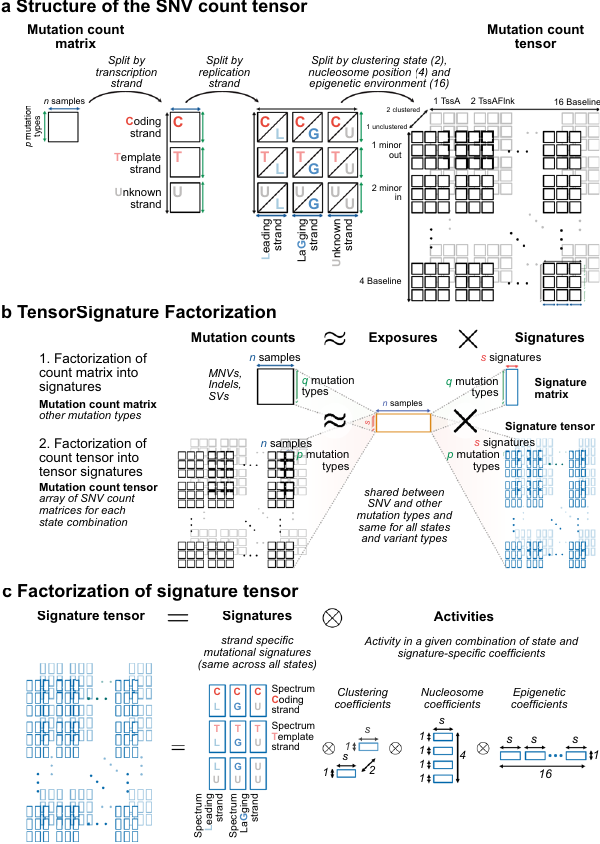
Fig. 1 A multidimensional tensor factorisation framework to extract mutational signatures. a Splitting variants by transcriptional and replicational strand, and genomic states creates an array of count matrices, a multidimensional tensor, in which each matrix harbours the mutation counts for each possible combination of genomic states. b TensorSignatures factorises a mutation count tensor (SNVs) into an exposure matrix and signature tensor. Simultaneously, other mutation types (MNVs, indels, SVs), represented as a conventional count matrix are factorised using the same exposure matrix. c The signature tensor has itself a lower dimensional structure, de fi ned by the product of strand-speci fi c signatures, and coef fi cients re fl ecting the activity of the mutational process in a given genomic state